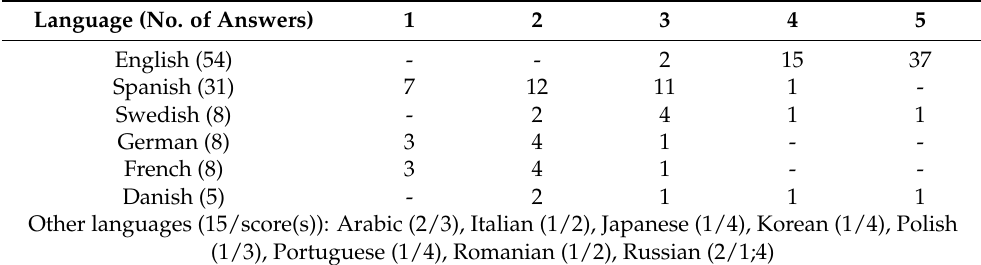
Table 3. Participants’ self-reported additional language competence on a 5-point scale from “not at all confident” (1) to “very confident” (5). Language (No. of Answers)